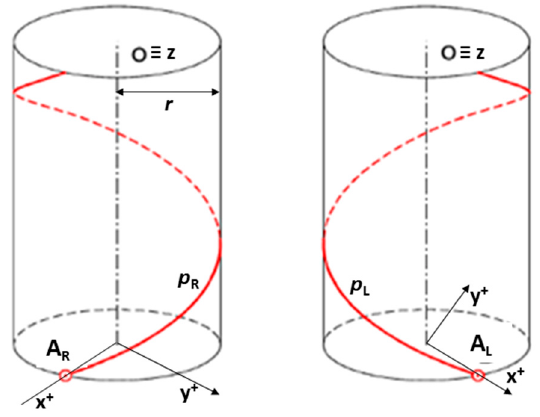
Figure 3. Right-handed helix p R with initial point A R and left-handed helix p L with initial point A L